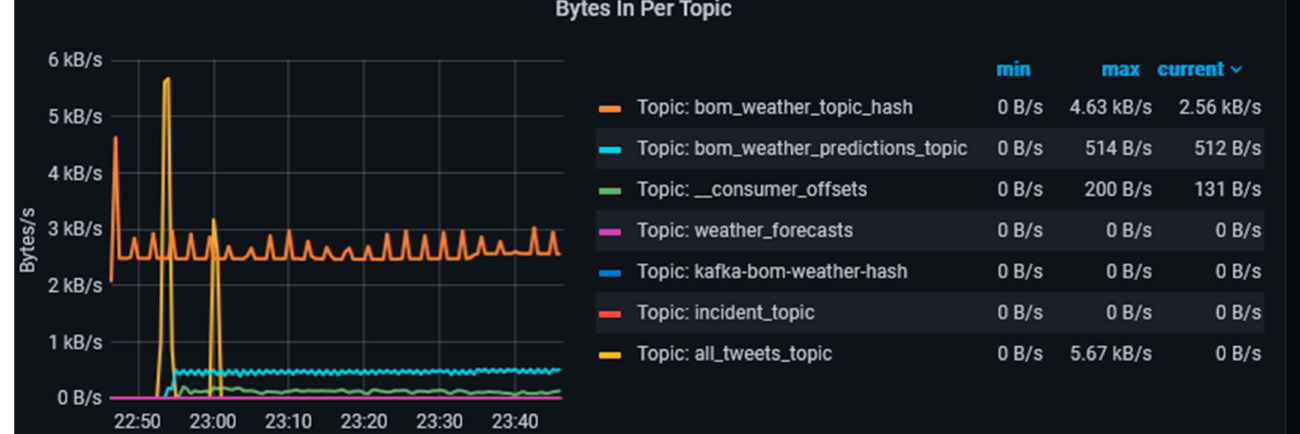
Figure 7. Bytes into each topic to determine the load being generated by each topic.